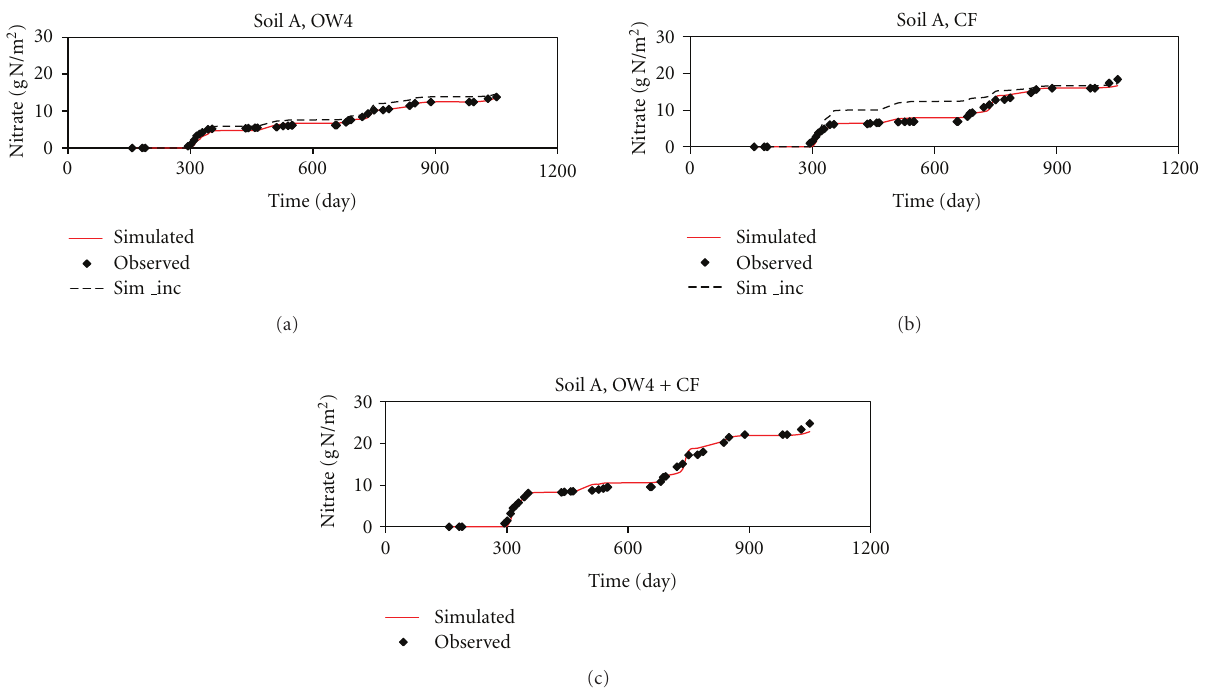
Figure 3: Application of organic matter to soil A. Simulated and observed NO 3 − -N leaching [gN m − 2 ] (accumulated values).